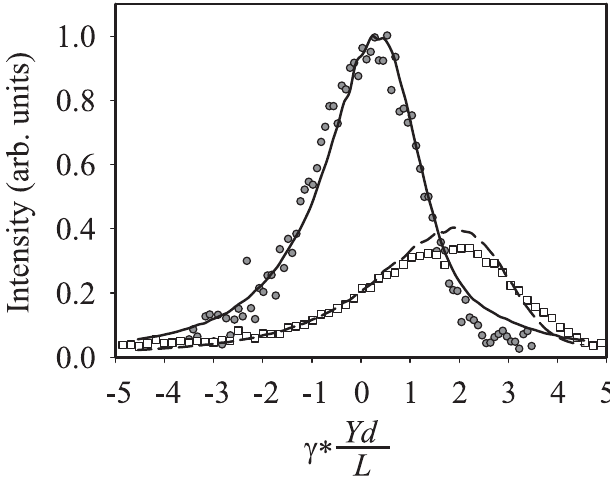
impact parameter. Gray dots—spherical target experiment; white squares—flat target experiment; solid line—spherical target theory; dashed line—flat target theory; dotted line—single elec- tron far-field approach.